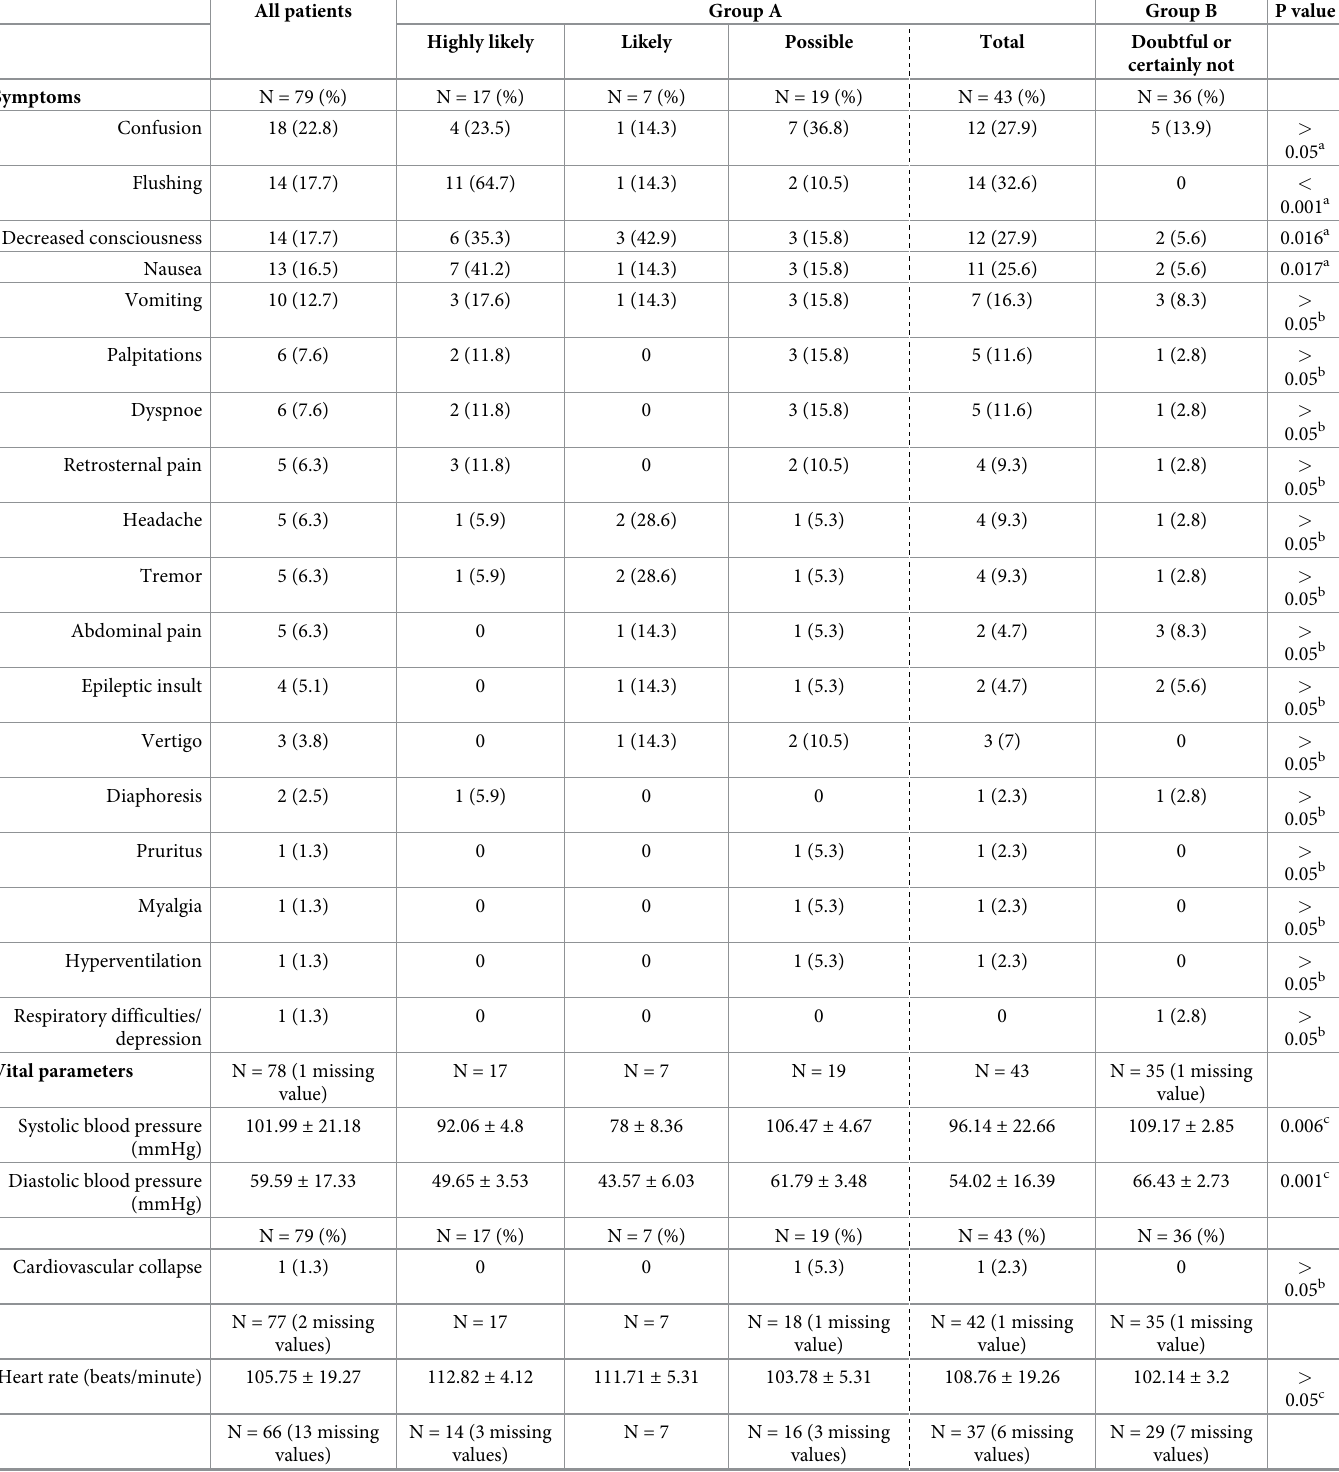
Table 3. Clinical characteristics and outcome in patients with a history of DIS treatment and ethanol use admitted to the ED of the University Hospital of Ghent between October 1, 2010 and September 30, 2014. Patients are grouped (A and B) according to the likelihood of a DER as attributed by the panel. All patients Group A Group